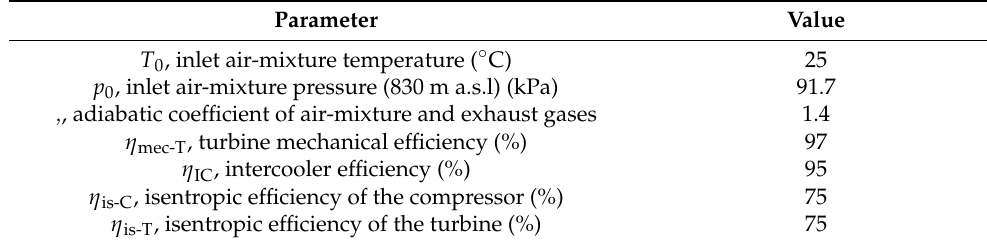
Figure 3. Turbocharger schematic diagram. Table 5. Compressor and turbine calculation